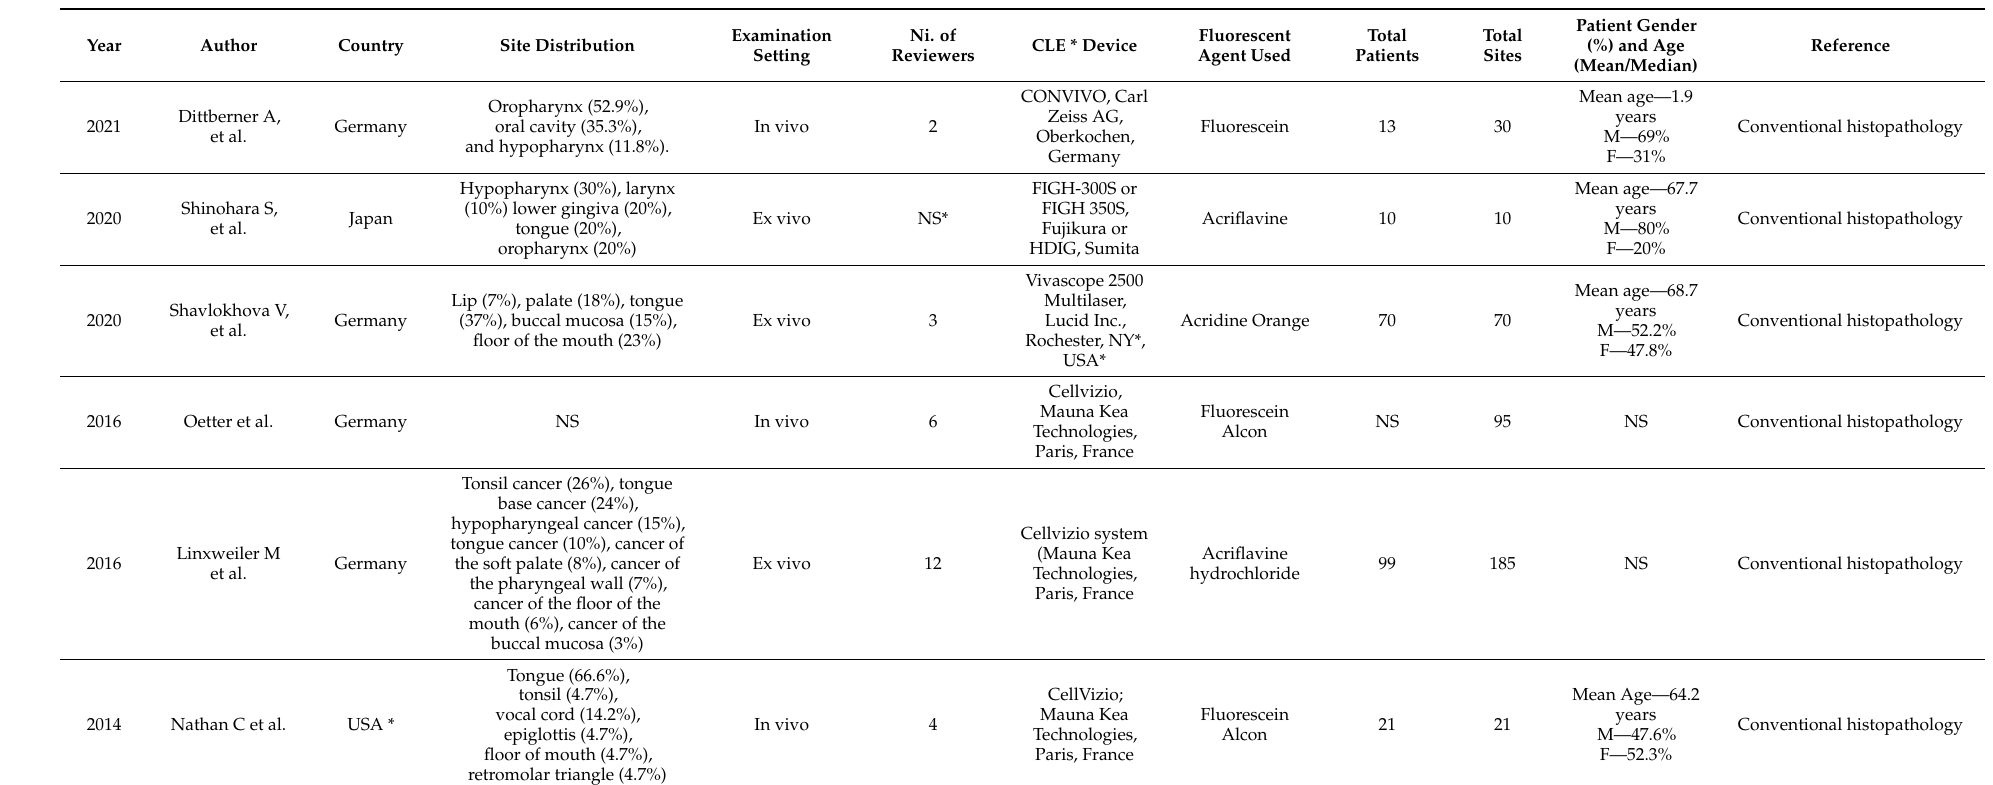
Table 1. Characteristics of included